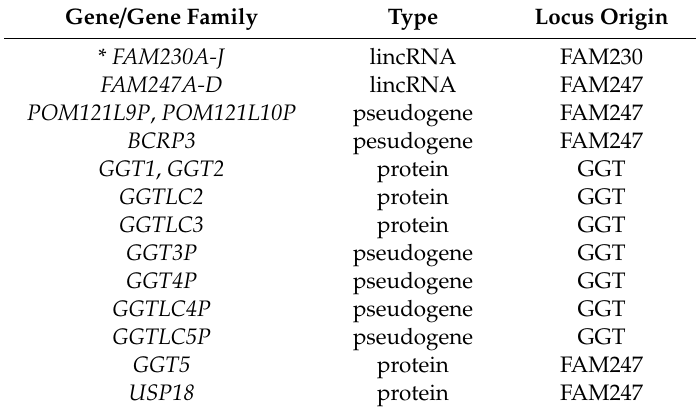
Table 1. Humangenesandgenefamiliesfoundinlinkedsequences: FAM230–FAM247–GGT,FAM230–USP18. Gene / Gene Family Type Locus Origin *